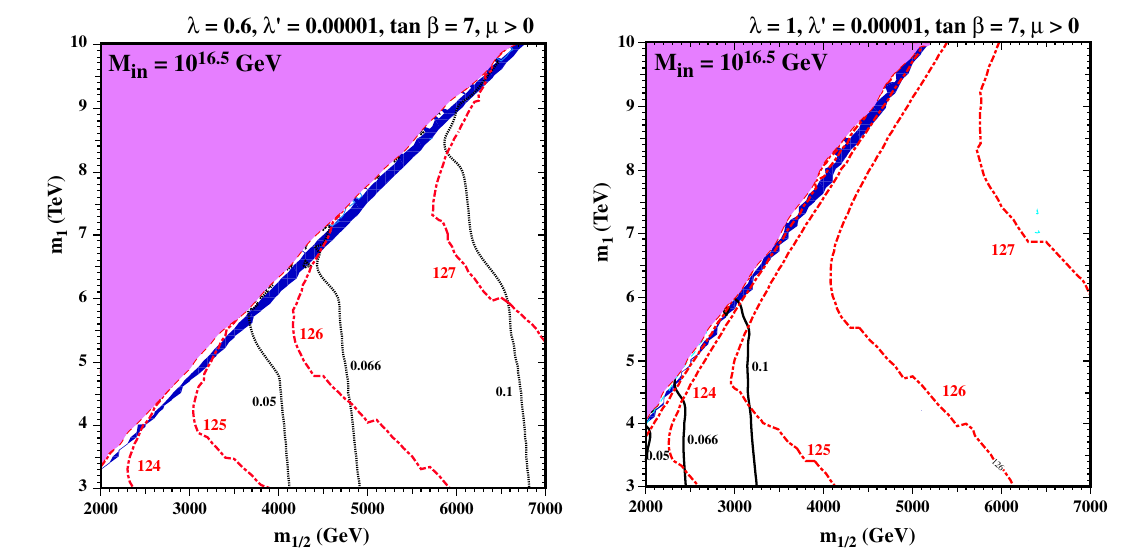
Fig. 3 Examples of ( m 1 / 2 , m 1 ) planes for M in = 10 16 . 5 GeV when both Higgs 5-plets are twisted. All the modular weights α i = β i = 0, corresponding to A t , b = m 1 , A λ = 2 m 3 / 2 , A λ (cid:2) = 0, B H = 2 m 1 , and B (cid:3) = 0. In both panels tan β = 7 and λ (cid:2) = 10 − 5 with λ = 0 . 6 ( left )